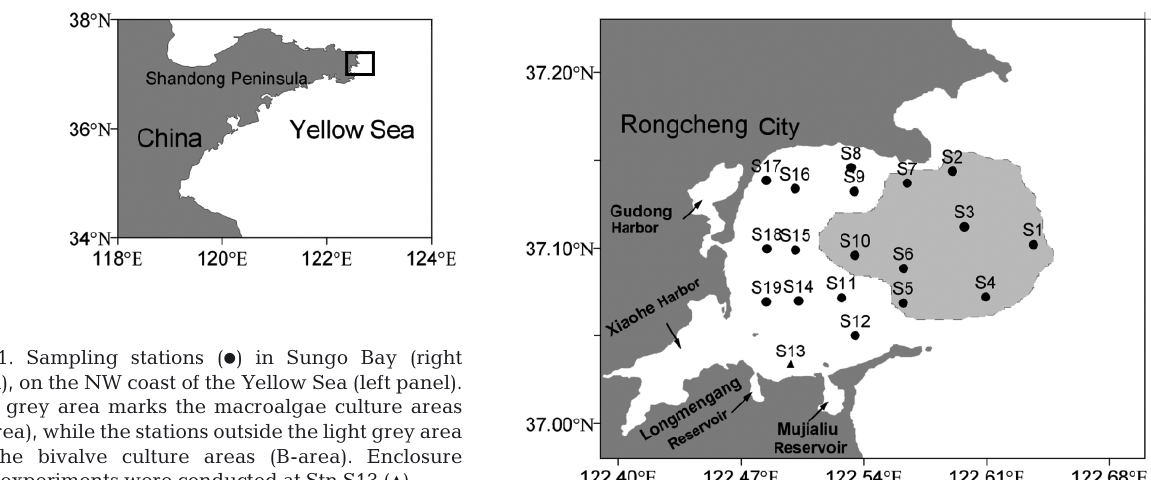
Fig. 1. Sampling stations ( d ) in Sungo Bay (right panel), on the NW coast of the Yellow Sea (left panel). Light grey area marks the macroalgae culture areas (M-area), while the stations outside the light grey area are the bivalve culture areas (B-area). Enclosure experiments were conducted at Stn S13 ( M